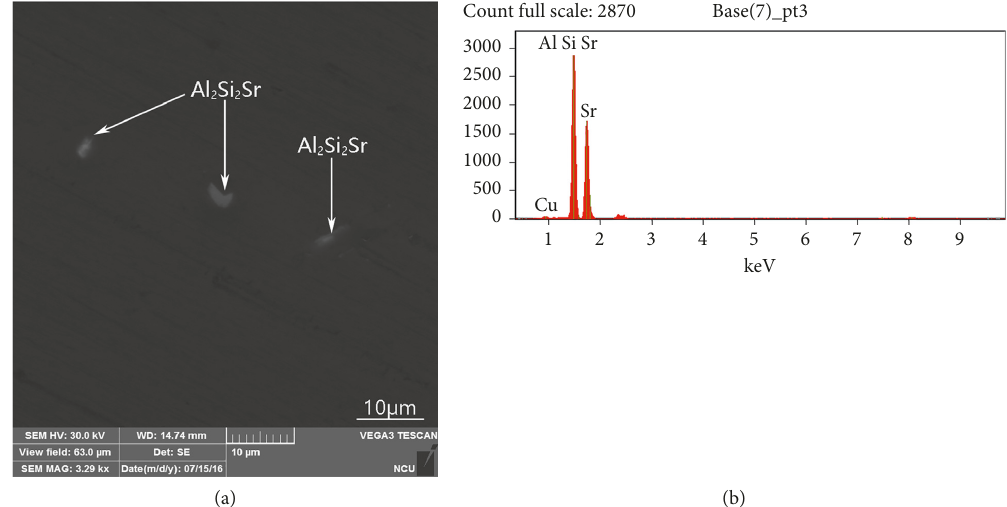
Figure 7: SEM-EDS image of Sr-rich intermetallic compounds in Al-7 wt.% Si alloy with 0.05 wt.% Sr. (a) SEM image of Sr-rich in- termetallic compound; (b) EDS spectrum obtained from the Al-Si-Sr